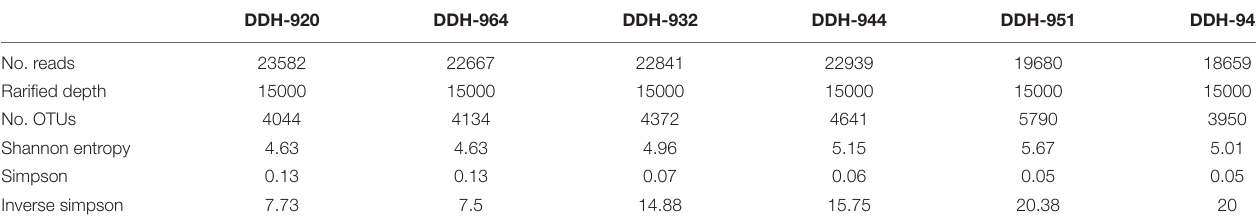
TABLE 5 | Diversity of borehole microbial communities. Boreholes are ordered (Left to right) to correspond with table one and signify whether the boreholes are horizontal (DDH-920 and DDH-964) or downward (DDH-932, DDH-944, DDH-951, and DDH-942).